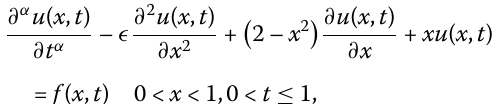
are plotted in Fig. 1. It is clearly observed that the spatial errors appear in an exponential decay for our method. Figure 2 presents the graph of the numerical solution and the exact solution with α = 0.5, N = 128, and τ = 1 . From these diagrams, it can be seen that our 1000 scheme gives a good approximation to the exact solution at mesh